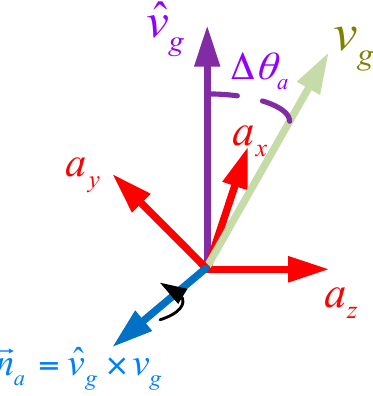
Figure 3. Correcting the estimated direction of gravity using the accelerometer.